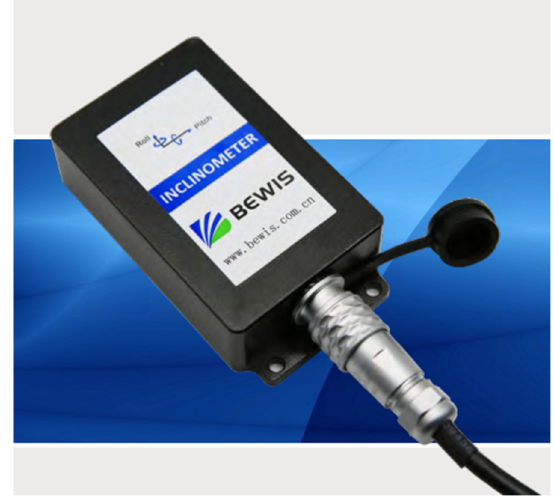
Figure 7. BW-VG527 Inclinometer. Table 3. Main technical parameters of a BW-VG527 inclinometer.